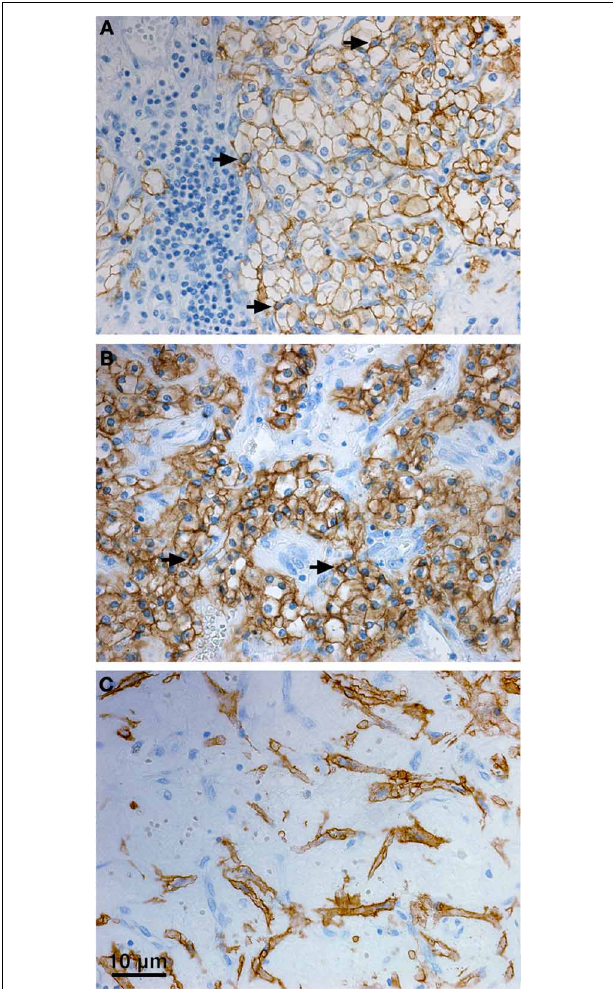
FIGURE 3 | Distribution of CA IX in the tumor tissue specimen from CCRCC patients. Immunohistochemical staining pattern of CA IX shows positive staining signal predominantly localized in the plasma membranes (A) , but also in cytoplasm (B) , and perinuclear regions (arrows, A, B) of the tumor cells. Moreover, CA IX can be detected in the stromal cells (C) . Tissue processing and staining procedures were as described in Takacova et al. (2013). Briefly, dissected tissues were embedded in paraffin according to the standard histological procedure and sectioned. Immunohistochemistry was performed on an automated immunostainer (Dako) using M75 antibody (hybridoma medium diluted 1:100) and DakoCytomation Envision® + System-HRP according to the manufacturer’s instructions. Staining was visualized with DAB solution for 1min with 3,3 (cid:2) -diaminobenzidine as a chromogenic substrate. Finally, the stained sections were counterstained with Mayer’s hematoxylin, mounted,